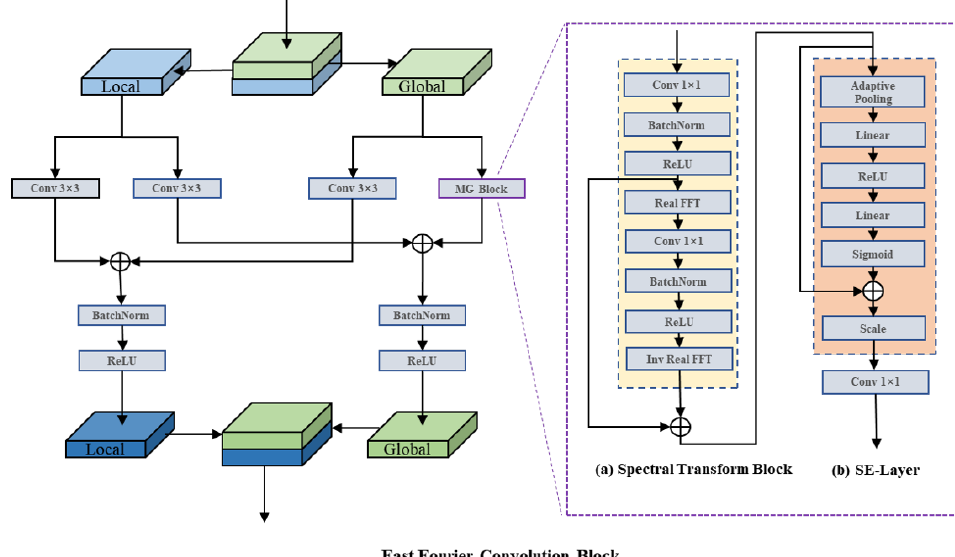
Figure 6. The architecture of the Fast Fourier Convolution Block (FFC